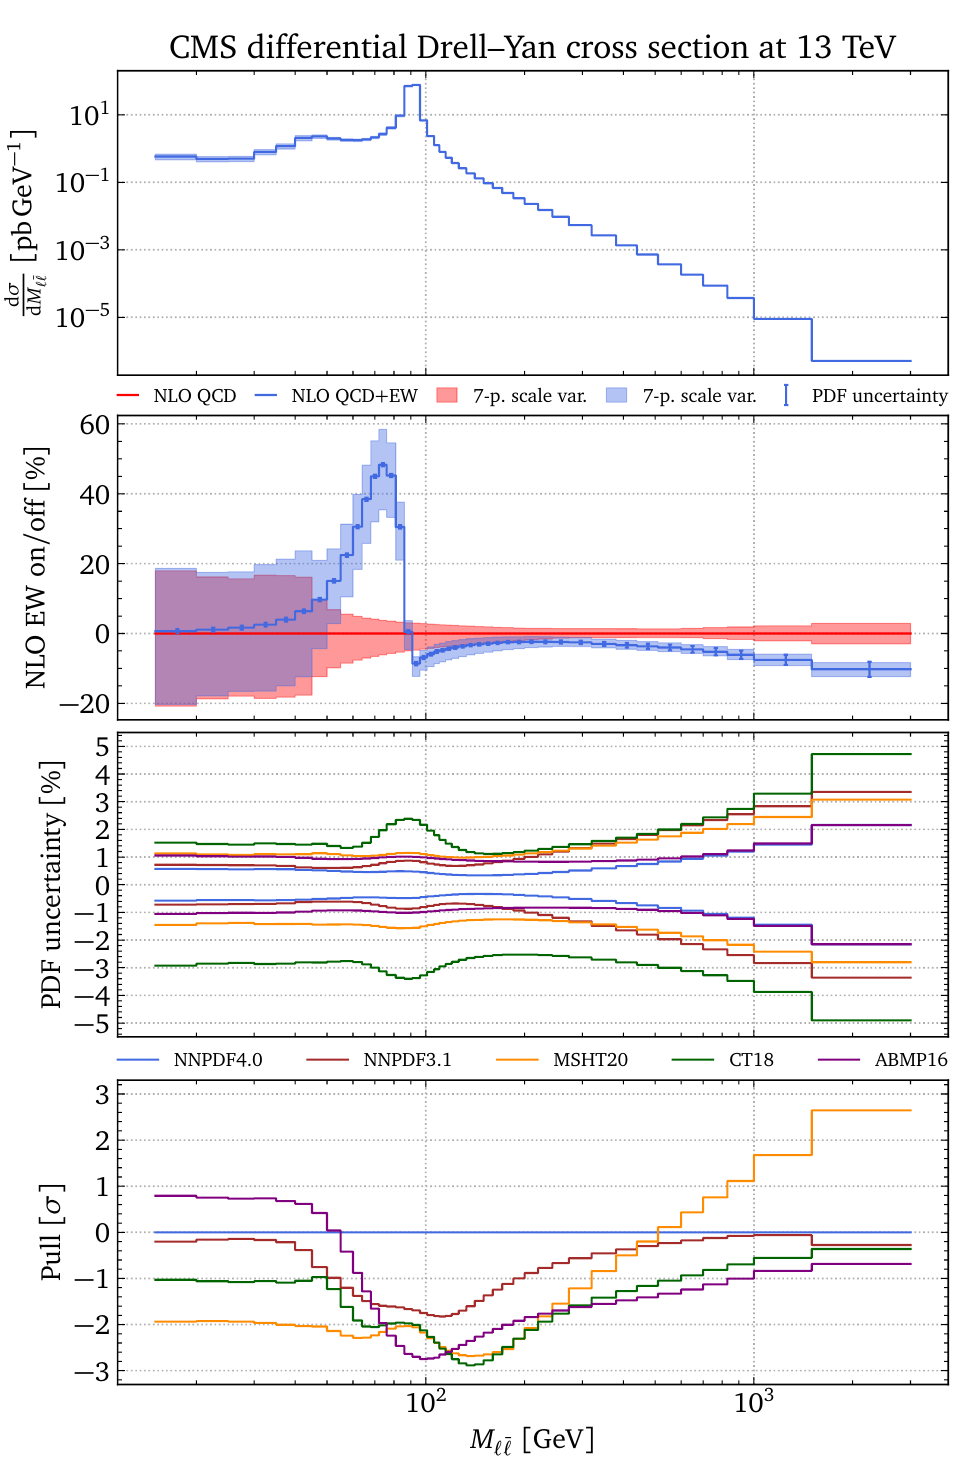
Figure 1: Theoretical predictions for the CMS DY lepton-pair production at 13 TeV. Top panel: absolute prediction for the cross section differentially in the invari- ant mass of the lepton pair. Second panel: NLO EW + QCD predictions relative to NLO QCD only. Third panel: PDF uncertainties for the four global PDF sets NNPDF4.0 (preliminary fit), MSHT20, CT18 and ABMP16. Bottom panel: Pull be- tween NNPDF4.0 and the remaining three PDF